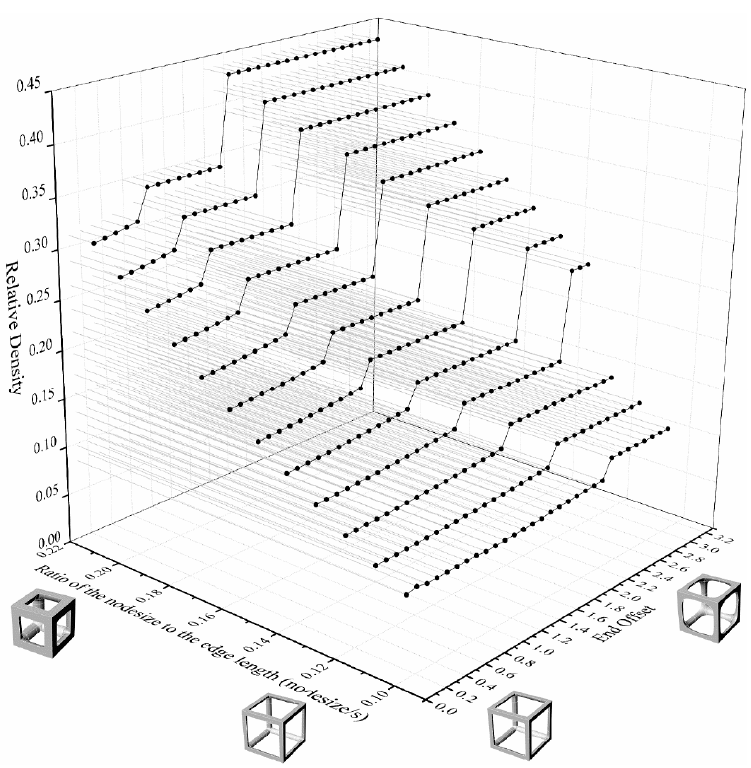
Figure 11. Design database for multipipe edgeless simple cubic lattice structure with the ratios of the node size to the edge length and end o ff set.